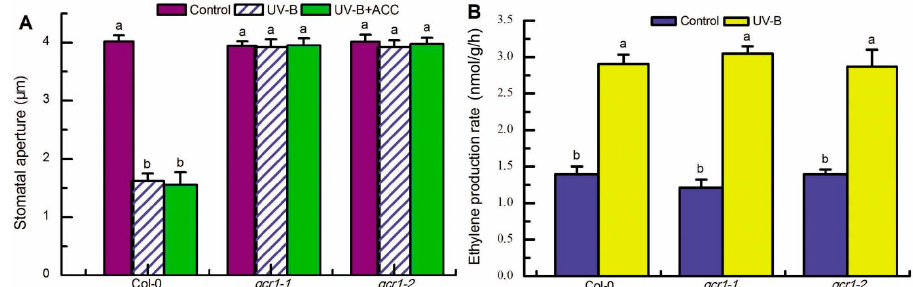
Figure 7. Ethylene acted upstream of GCR1 in UV-B guard cell signaling. Leaves of the wild-type Col-0 and gcr1 mutants were floated on MES buffer in the absence or presence of 100 μ mol/L ACC (ACC) and exposed to light alone (Control) or with 0.5 W/m 2 UV-B (UV-B) for 3 h. Then the stomatal apertures were measured in the epidermal strips ( A ), or ethylene production rate was analyzed in the treated leaves by gas chromatography ( B ). Data are shown as means ± SE ( n = 3), and means with different letters are significantly different at p < 0.01.